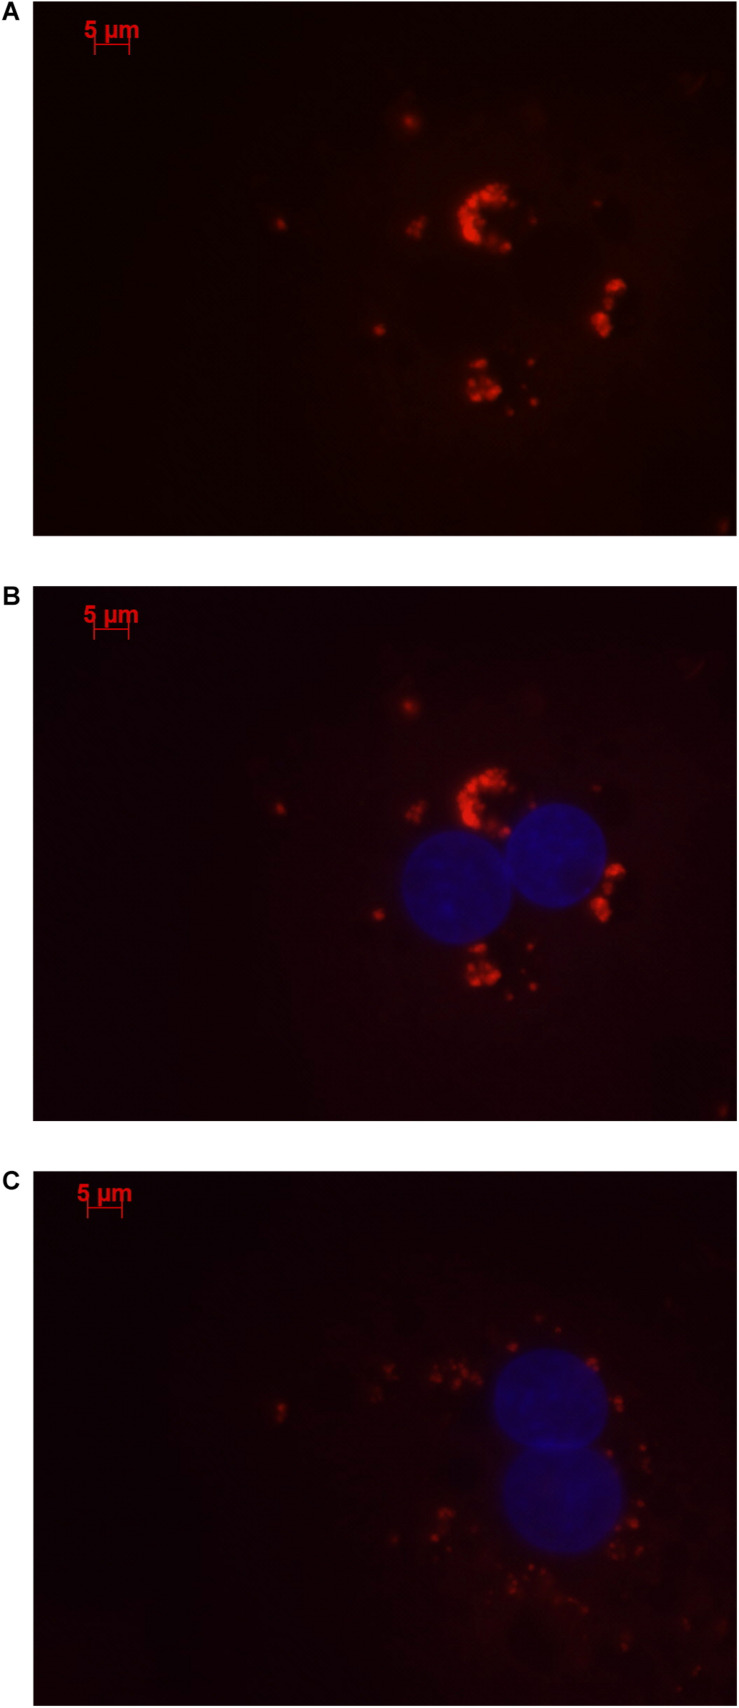
Human hepatocytes stained using Stellaris RNA FISH show that lncRNA LOC157273 localizes to distinct punctate foci in the cytoplasm. The red staining (63 × oil, 500 ms, 568 nm) in human hepatocytes with rs4841132 G/G genotype (A,B) or with rs4841132 A/G genotype (C) shows cytoplasmic punctate foci containing LOC157273, a pattern consistent with the possible localization of this lncRNA in cytoplasmic riboprotein (protein–RNA) complexes. Blue staining indicates hepatocyte nuclei.